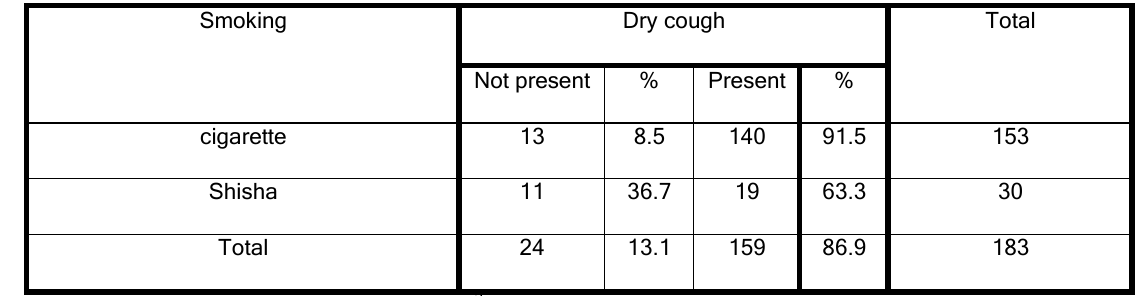
Table 6 show the relation of dry cough according to mode of smoking among